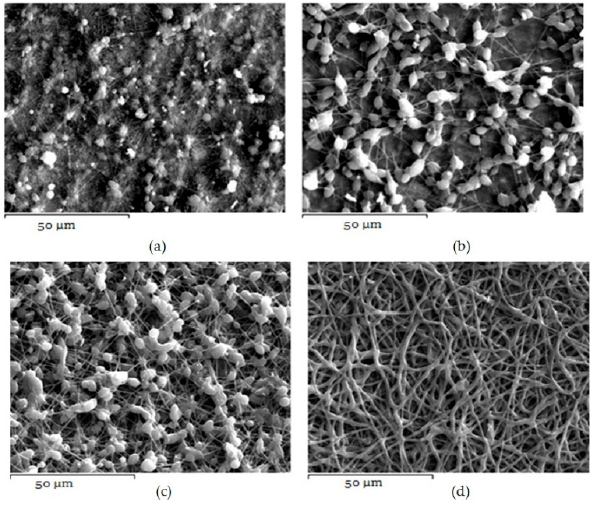
Figure 2. PCL fibers prepared using different concentrations of PCL in DCM/DMF-70/30 v / v mixture. ( a ) 5%; ( b ) 10%; ( c ) 15%; and ( d ) 20% w / v .